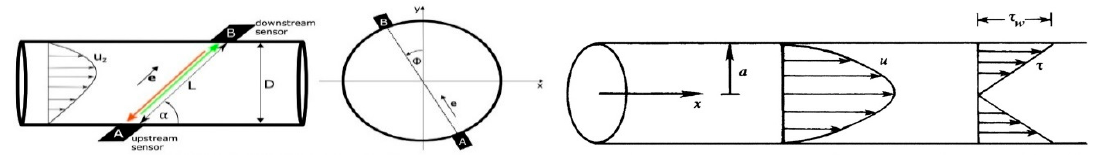
Figure 9. Impact factors for forces acting inside hose .